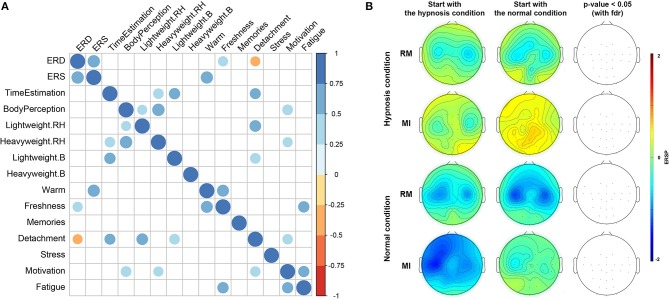
(A) Correlogram representing Spearman's correlations among the 12 items contained in the questionnaires, and ERD and ERS variation differences between normal and hypnotic conditions. Correlations with a p-value > 0.05 are considered as not significant and are shown in blank. Positive correlations are displayed in blue and negative correlations are in orange. The intensity of the color and the size of the circles are proportional to the correlation coefficients. (B) Topographic maps representing differences in term of ERSPs for the sequence in which the conditions (hypnotic and normal) were achieved for each subject. Red corresponds to a strong ERS and blue to a strong ERD. Significant difference (p < 0.05) with a False Discovery Rate (FDR) correction are shown in the right part of the figure.